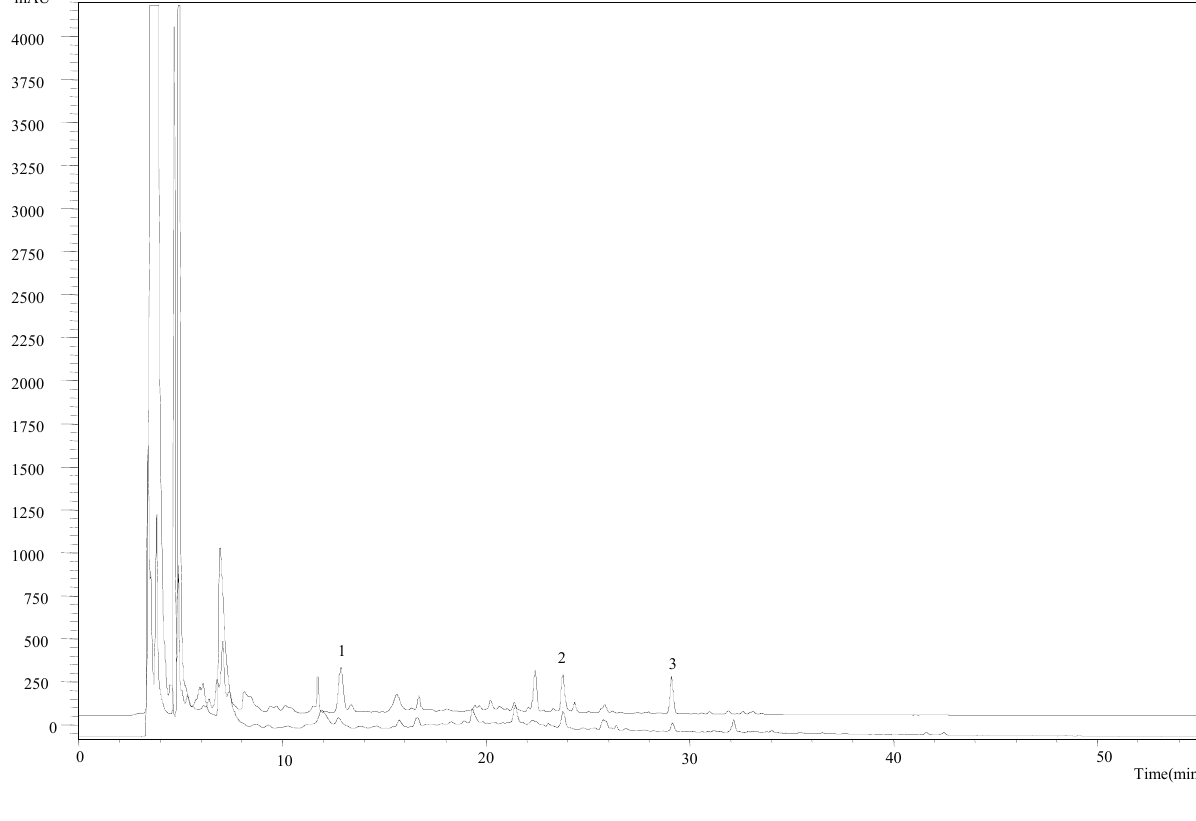
Figure 1. Phenolic acids profile of Ganoderma lucidum cold extract (-----) and room temperature extract ( _____ ). 1— p -Hydroxybenzoic acid; 2— p -coumaric acid; 3—cinnamic